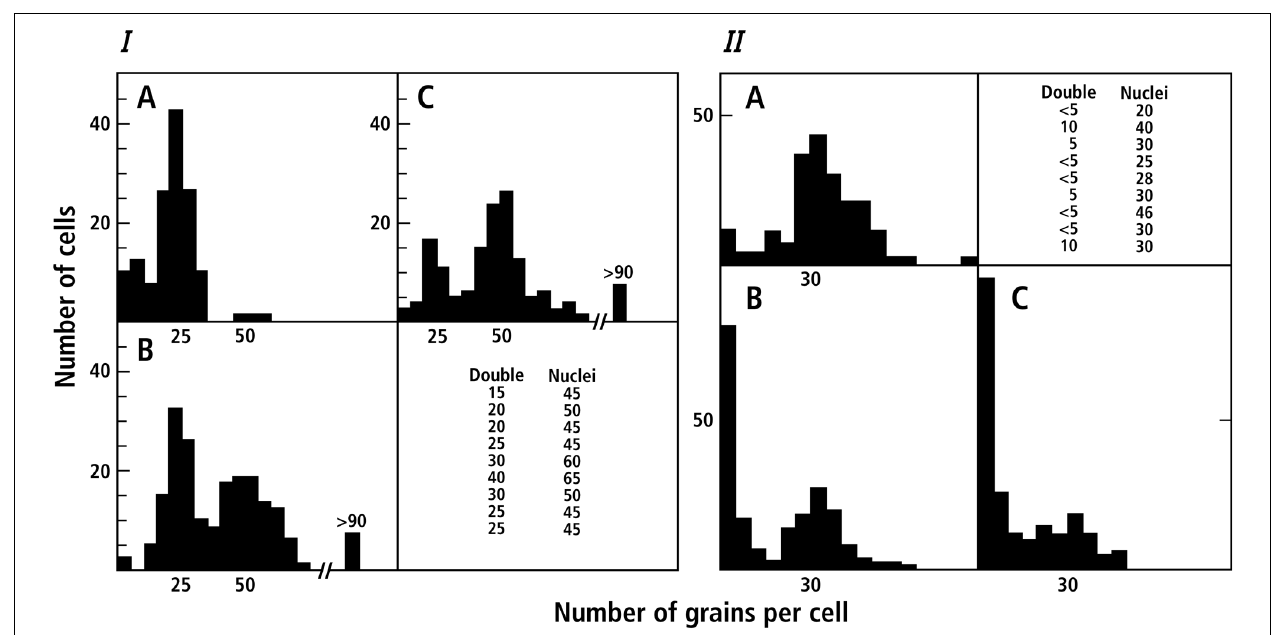
FIGURE 2 | Non-random segregation of radioactive chromosomes in primary cultures of mouse embryo cells (data taken from Figures 1 and 2 of Lark etal., 1966). Distribution of silver grains in autoradiographs of mouse embryo cells: (I) Grown as a primary tissue culture for 1, 2, or 3 generations in H3-thymidine (0.025 mc/ml). (A) An inoculum of 2.5 × 10 6 cells per Petri dish (100 mm) was grown for 24 h. (B) 1.25 × 10 6 cells were grown for 48 h. (C) 0.63 × 10 6 cells were grown for 72 h. (II) Grown as a primary tissue culture for one generation in H3-thymidine (0.025 mc/ml) and for two